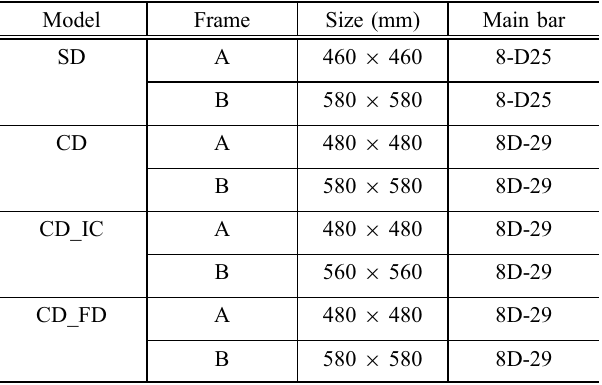
Table 4 Member size and rebars of the first story exterior columns designed using R = 5.